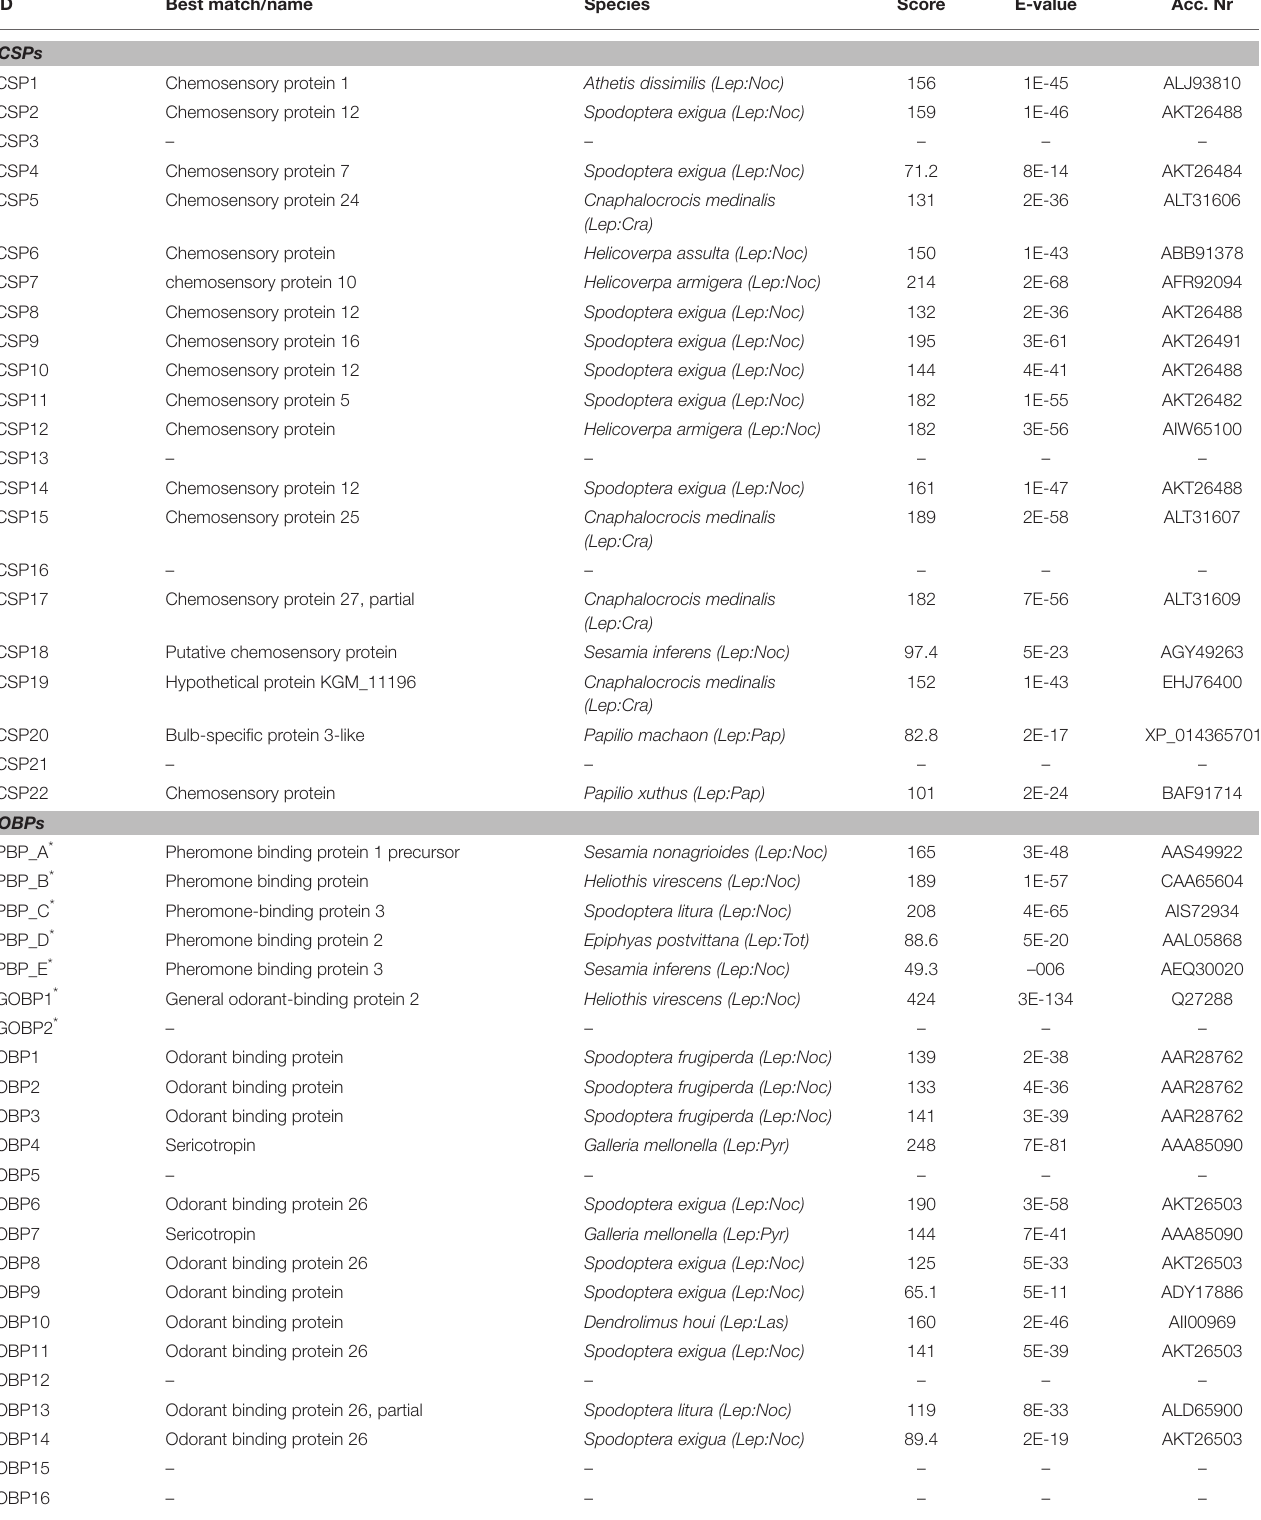
TABLE 2 | List of L. dispar transcripts putatively involved in chemoreception, and characterization for the best hit after comparison with available protein sequences using the BlastP algorithm.